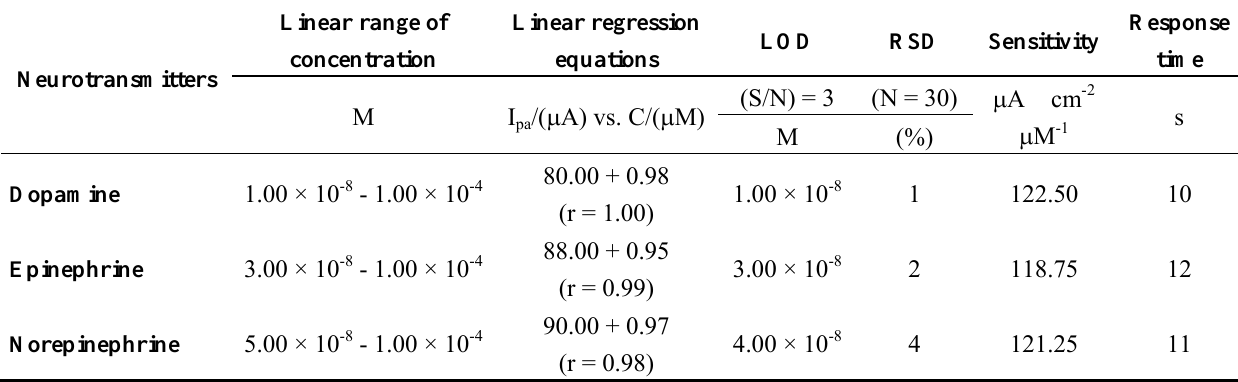
Table 1. Analytical parameters for TiO -modified Si electrodes toward dopamine, 2 epinephrine, and norepinephrine detection. Differential Pulse Voltammetric calibrations in 0.1 M phosphate buffer, pH 7.4 (20 mL) + 1 mM AA.